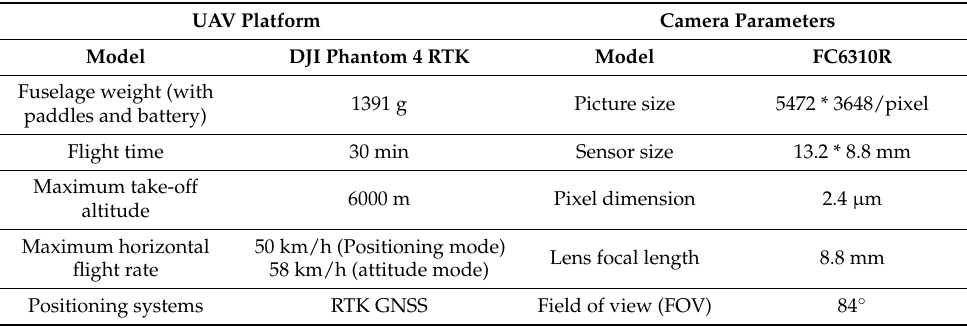
Table 1. DJI Phantom 4 RTK drone platform and camera